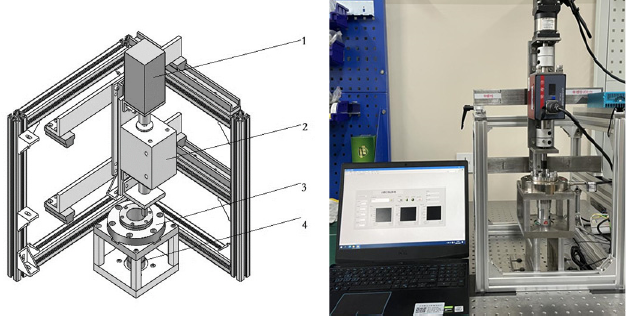
Figure 10. High-precision small-size screw connection tightening test platform. 1. Tighten the motor, 2. dynamic torque sensor, 3. pressure sensor, 4. static torque sensor.